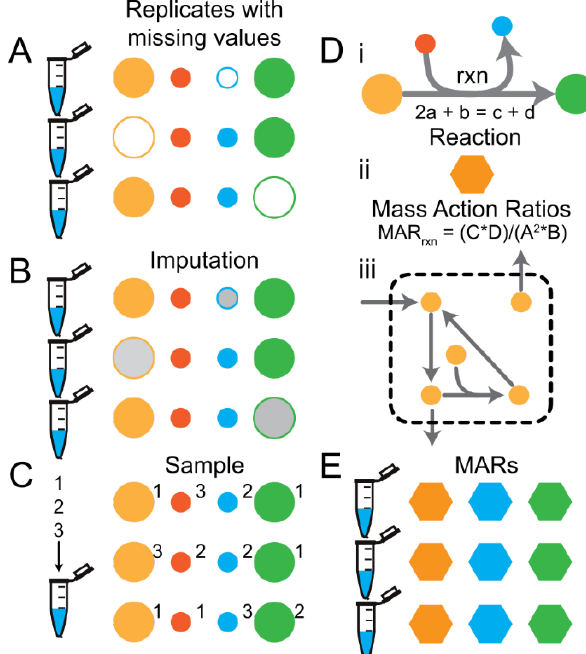
Figure 2. Missing value imputation methods. ( A ) Schematic of 3 replicate samples (eppi tubes) with 4 metabolite data points (circles). Filled circles indicate measured values and open circles indicate missing values. ( B ) Missing values are usually imputed (grey filled circles) prior to downstream machine-learning tasks. ( C ) Alternatively, the values for each metabolite from all replicates can be pooled and sampled to generate values for replicates on the fly. The numbers next to each circle indicate the replicate number from which the value came. ( D ) Overview of the procedure for calculating Mass Action Rations (MARs) for metabolomics data given a metabolic network stoichiometry. Please note that the number of features per sample changes from the number of metabolites measured to the number of metabolic reactions in the metabolic network. ( E ) MARs can be calculated by sampling the metabolite values from each